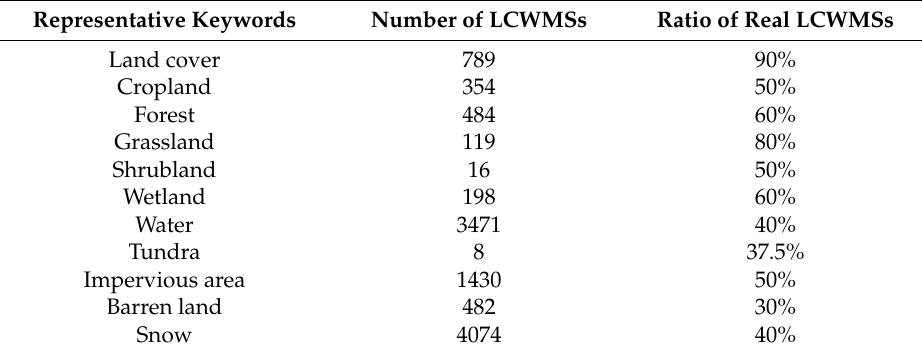
Table 8. Number of LCWMSs about each class and the average ratio of real